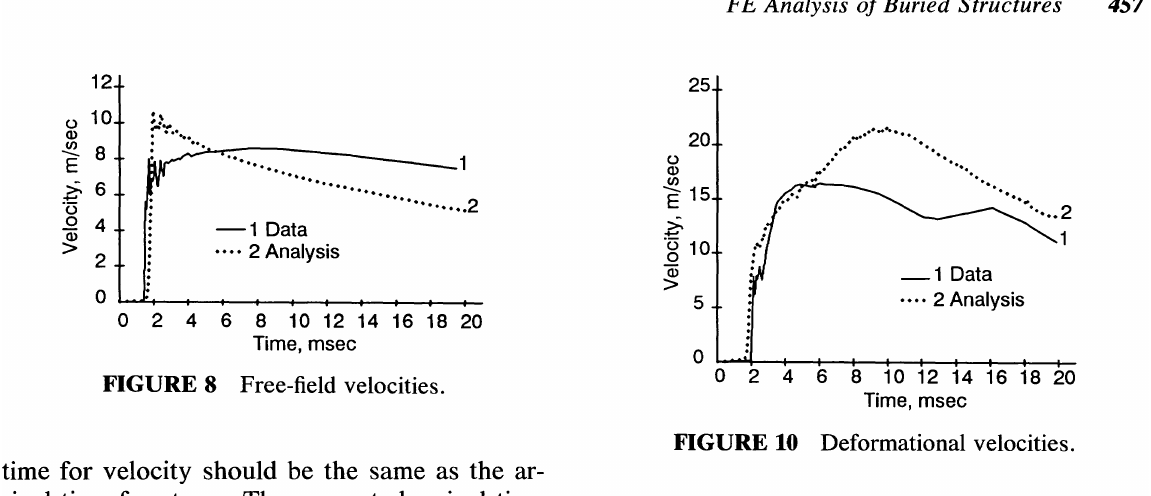
FIGURE 10 Deformational